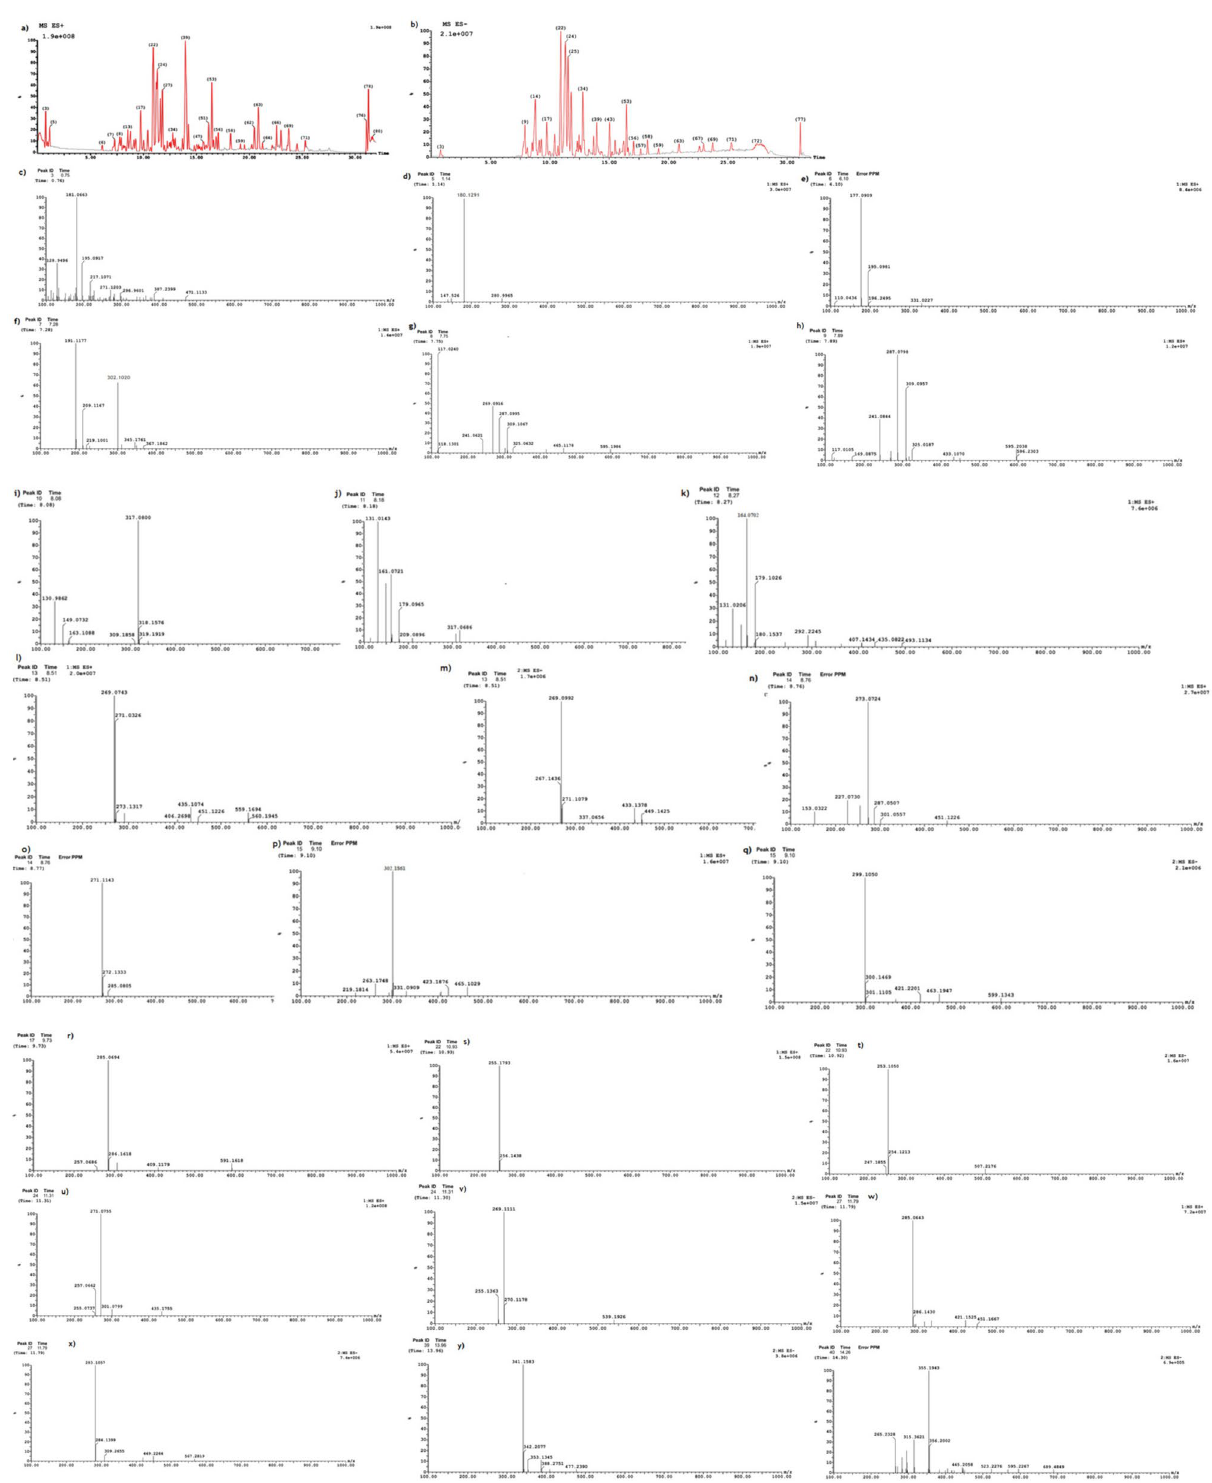
Figure 2. UPLC/ESI–MS analysis in the positive ion mode for